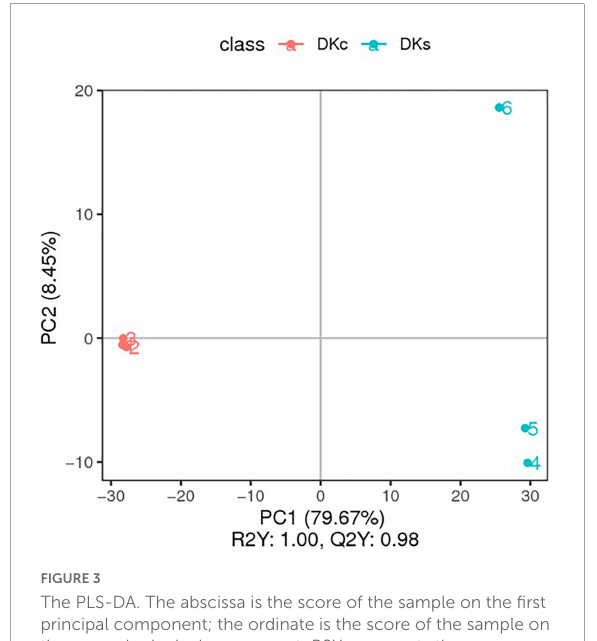
FIGURE4 The volcano plot of the different metabolites in different samples. The abscissa represents the fold change of metabolites in different groups (log2 Fold Change), the ordinate represents the significant level of difference (-log10 p -value), and each point in the volcano map represents a